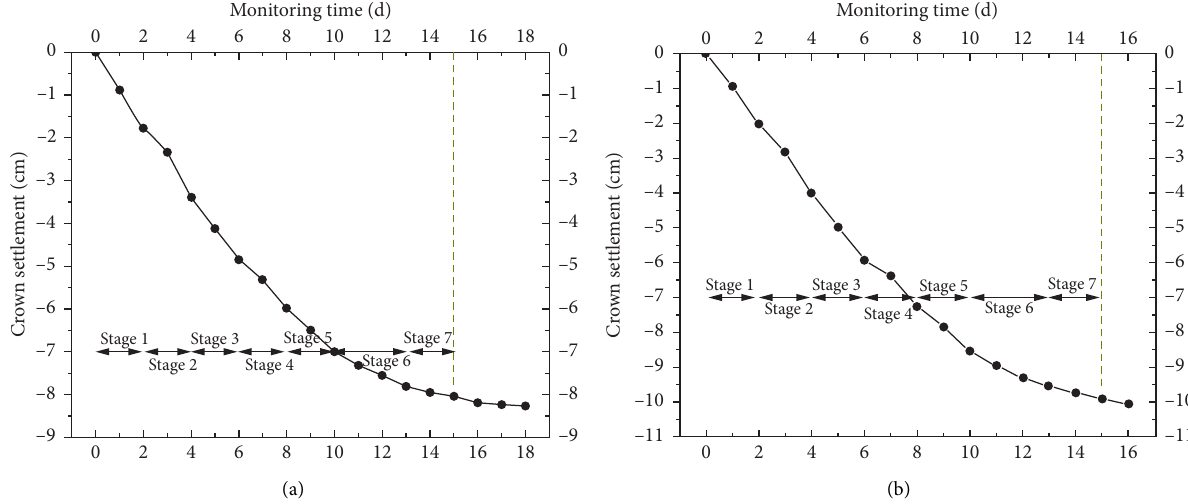
Figure 14: Measured crown settlement-time curves of section: (a) ZK1+260; (b) ZK1+310.